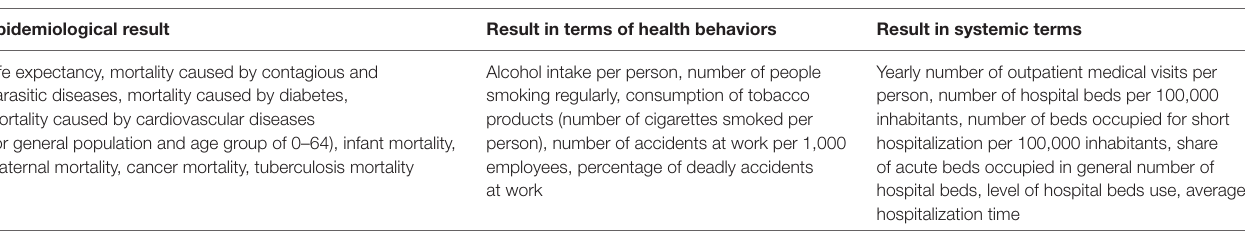
tAble 2 | Summary of measures constituting the SOM index. epidemiological result Result in terms of health